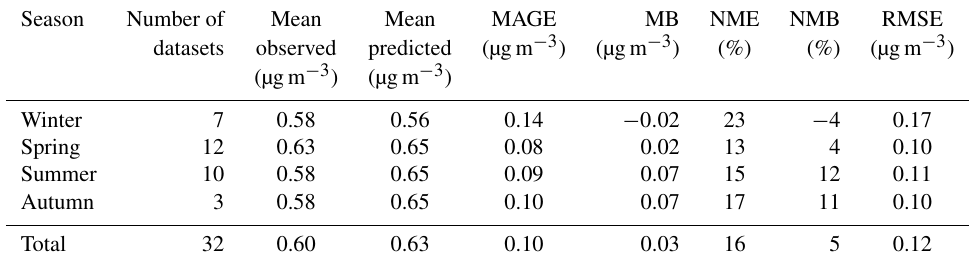
Table 8. Statistical evaluation of EMAC O:C ratio of OOA against observations from 32 datasets worldwide during 2001–2010. Season Number of Mean Mean MAGE MB NME NMB RMSE datasets observed predicted (µgm − 3 )